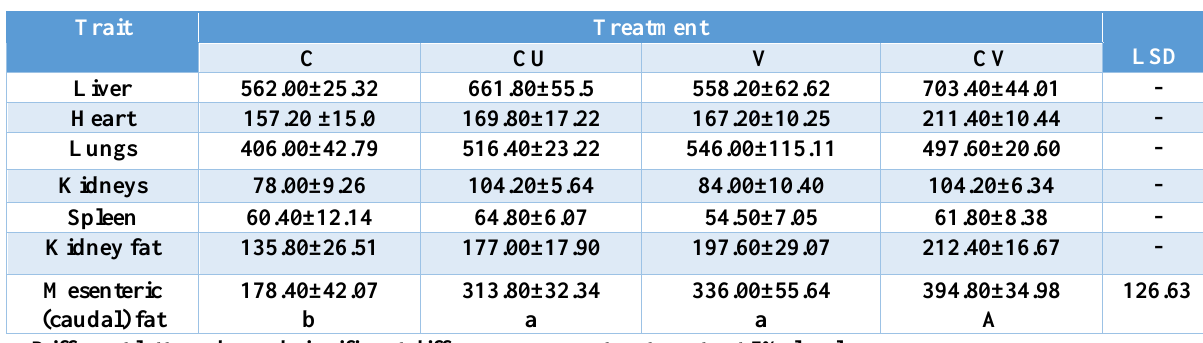
Table, 4: Effects of vasectomy and/or adding Cuminum cyminum in the diet on the weights of edible parts or organs (g) of Awassi male lambs (Mean±SE)